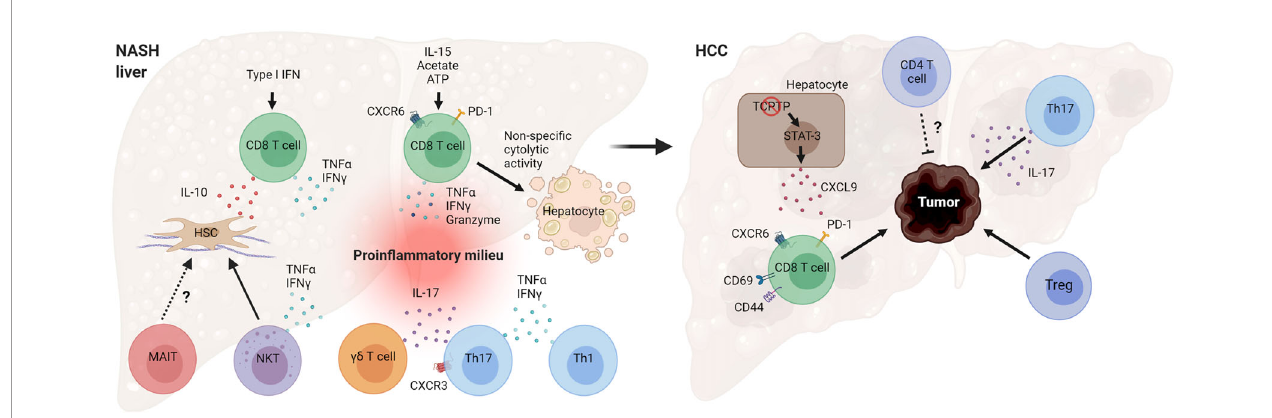
FIGURE 4 | Mechanisms by which T cells can promote NASH and HCC pathogenesis. Hepatic CD8 T cells in NASH secrete cytokines that promote hepatic stellate cell (HSC) activation and tissue in fl ammation. NASH-associated CD8 T cells can also cause non-speci fi c (antigen-independent) cell death of hepatocytes. T helper cells, Th17 and Th1, and gd T cells secrete effector cytokines during NASH, contributing to in fl ammatory tissue milieu. Loss of T cell protein tyrosine phosphatase (TCPTP) in hepatocytes leads to STAT-3-dependent secretion of CXCL9 and liver tumorigenesis. Programmed cell death protein 1 (PD-1)+ CD8 T cells, Tregs, and cytokine IL-17 promote HCC development, while CD4 T cells overall may decrease tumor burden and control tumor size. (Created with